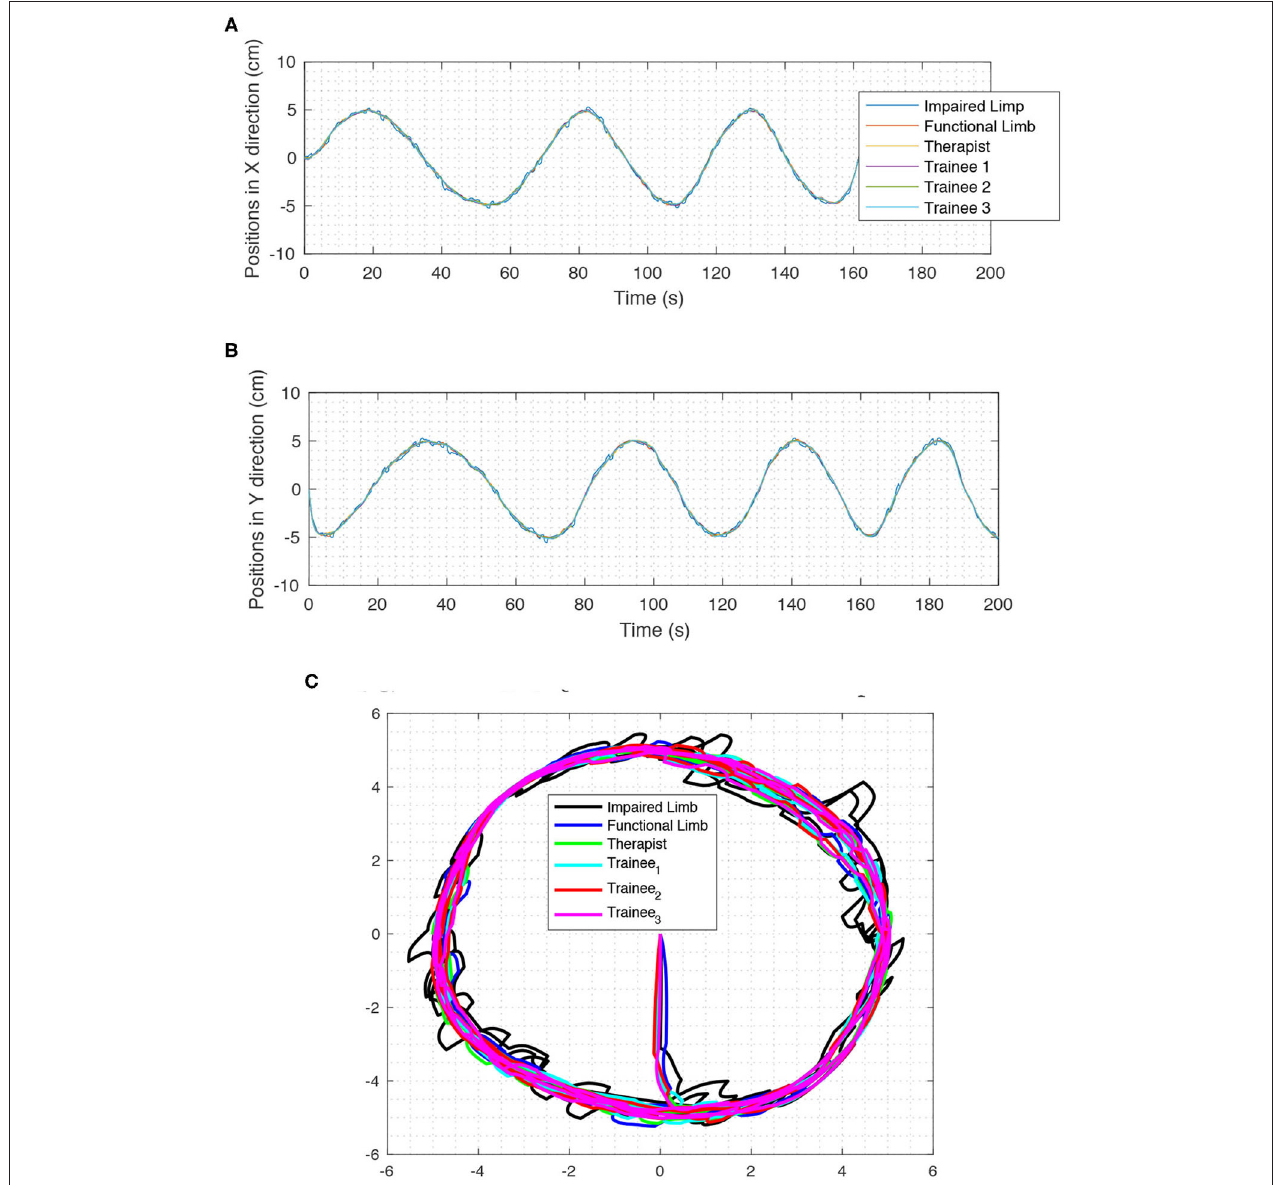
FIGURE 12 | The positions in STTRP. In this process, six operators participate in TR, simultaneously. impaired hand, functional hand, Therapist, and trainee #1, participate in the force interaction of TR process, and neither of these four operators is superior to the other. Operator #2 and #3 do not participate in the force interaction. (A) Positions in X direction in STTRP experiment. (B) Positions in Y direction in STTRP experiment. (C) Positions in 2D space in STTRP experiment (XY